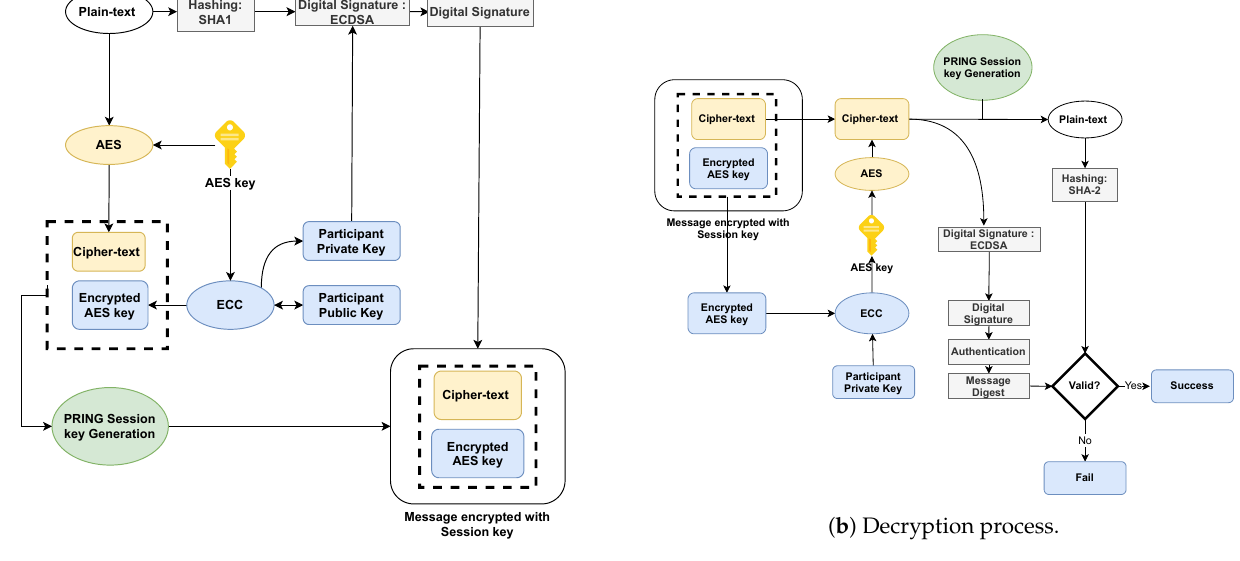
Figure 2. AES-ECC